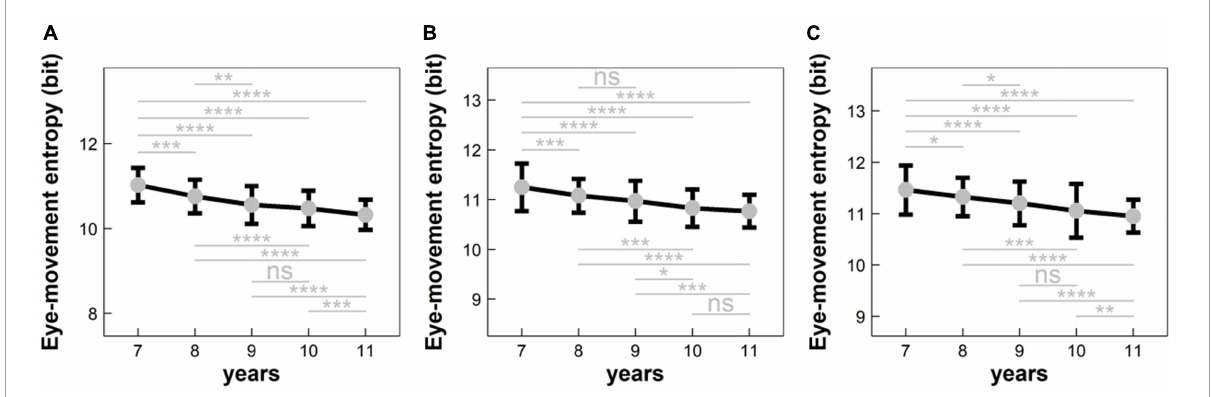
FIGURE3 Eye-movement entropy changed with the age in different conditions: (A) condition C1 (i.e., naming a series of numbers sequentially); (B) condition C2 (i.e., naming a series of numbers and Chinese characters sequentially); and (C) condition C3 (i.e., naming a series of numbers, Chinese characters, and colors sequentially). ns: p > 0.05; * p < 0.05; ** p < 0.01; *** p < 1 × 10 - 3 ; **** p < 1 × 10 − 4 .